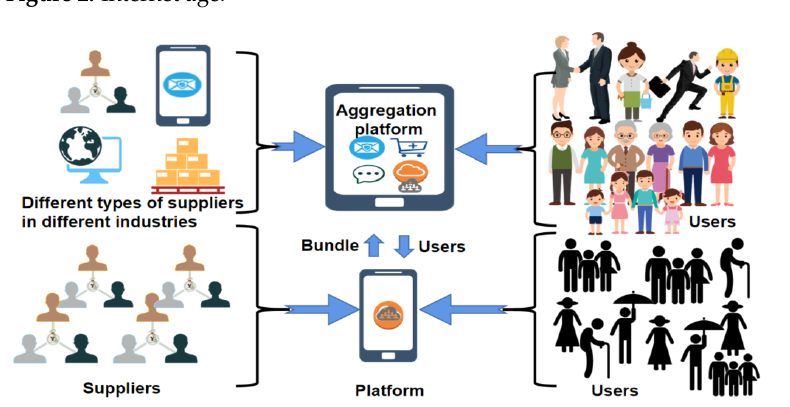
Figure 2. Internet age.